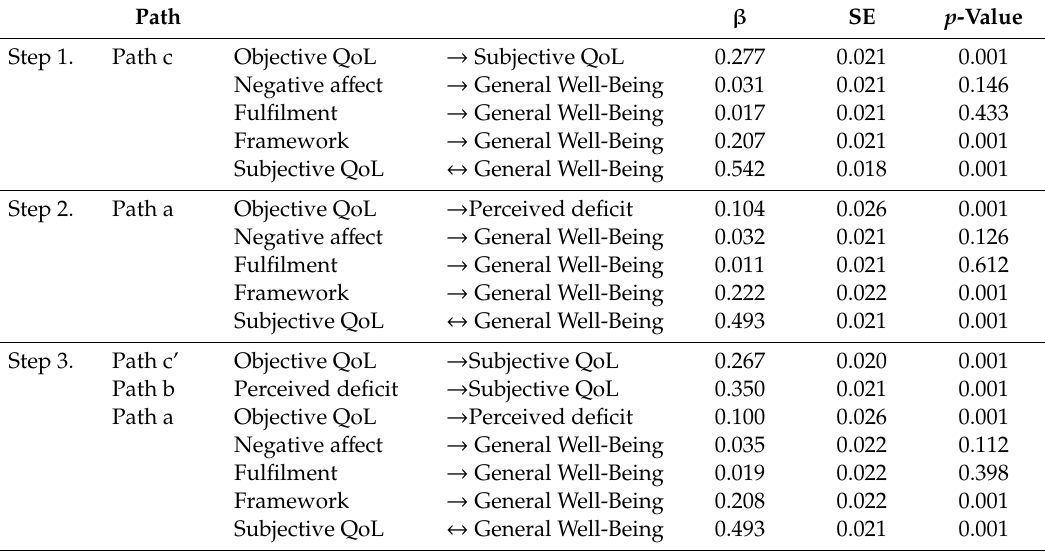
Table 3. Linear regression analyses predicting subjective Quality of life (QoL) and General Well-Being.